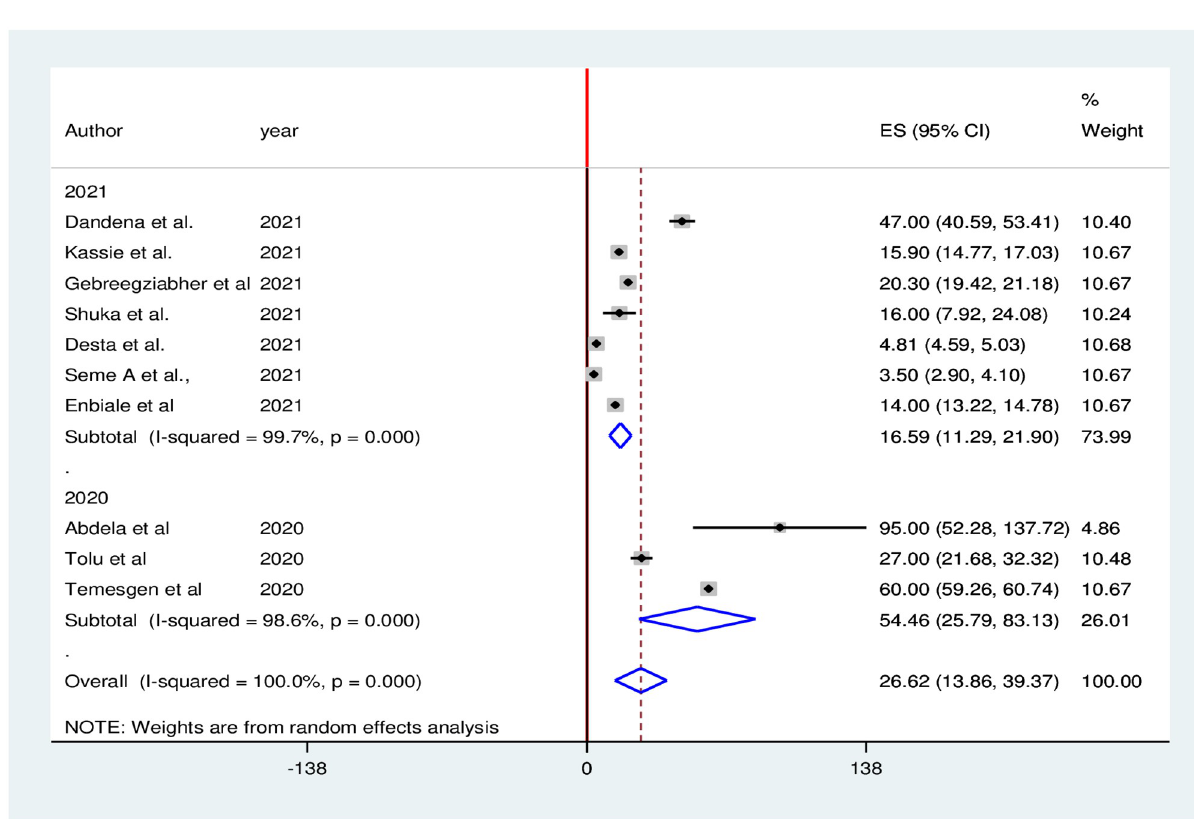
Fig 3. Subgroup analysis of family planning services reduction during the COVID-19 pandemic in Ethiopia, 2021.